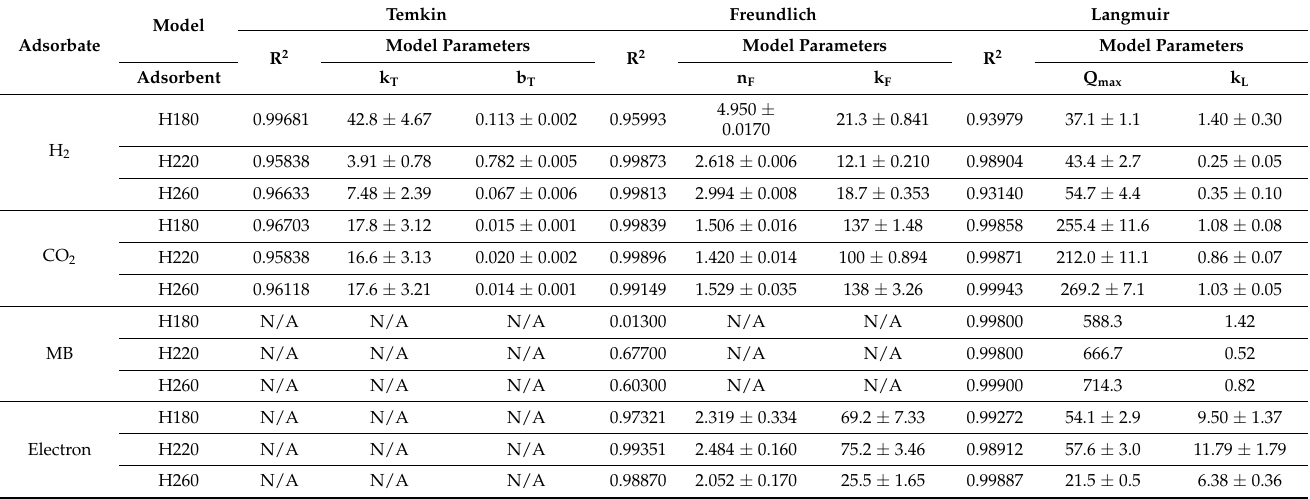
Table 3. Adsorption isotherm model fitting parameters for H 2 , CO 2 , dye and electron